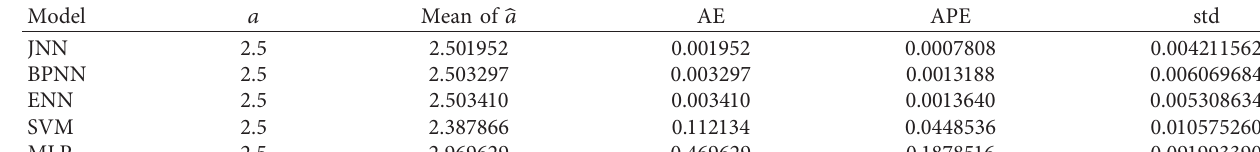
Table 3: Predicted value of a with different models.